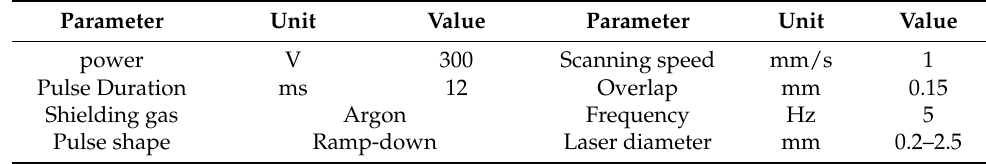
Table 2. Pulsed laser melting